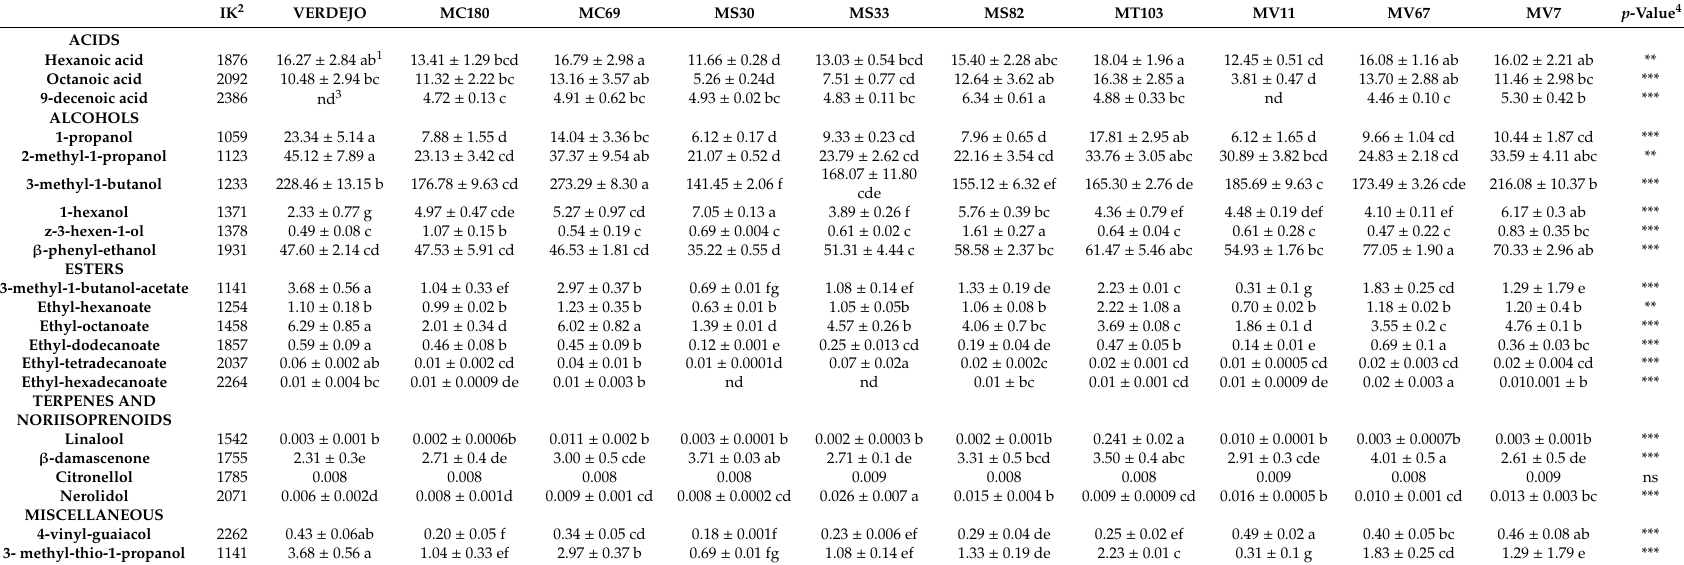
Table 4. Individual aromatic concentrations in wines (expressed as mgL -1 ) at the end of alcoholic fermentation in